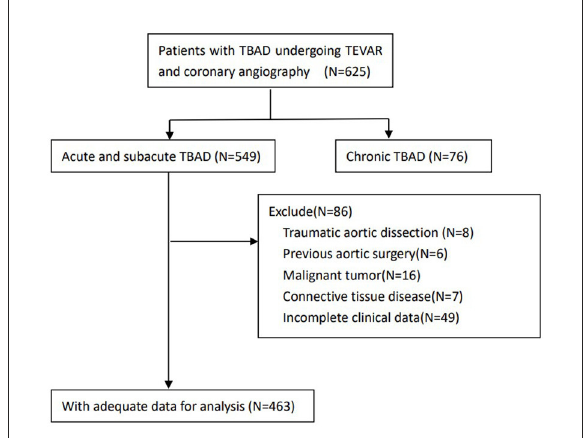
FIGURE1 Flow chart demonstrating the inclusion of patients in the study. TBAD, type B aortic dissection; TEVAR, thoracic endovascular aortic